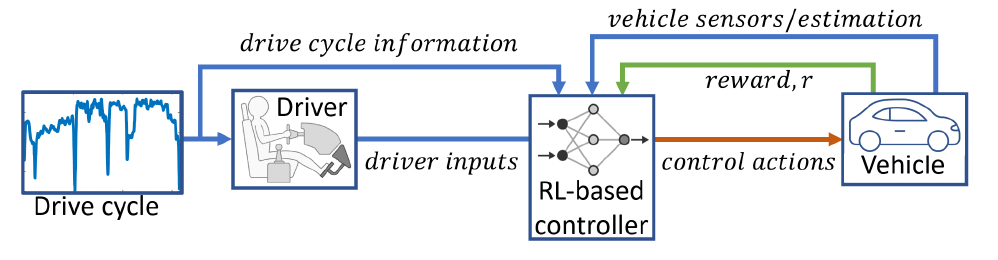
Figure 2. Example configuration of how an RL-based powertrain controller may exist within its environment. The environment can provide the RL-based controller information from a drive cycle, driver, and/or vehicle. Information can come directly from sensor measurements or an